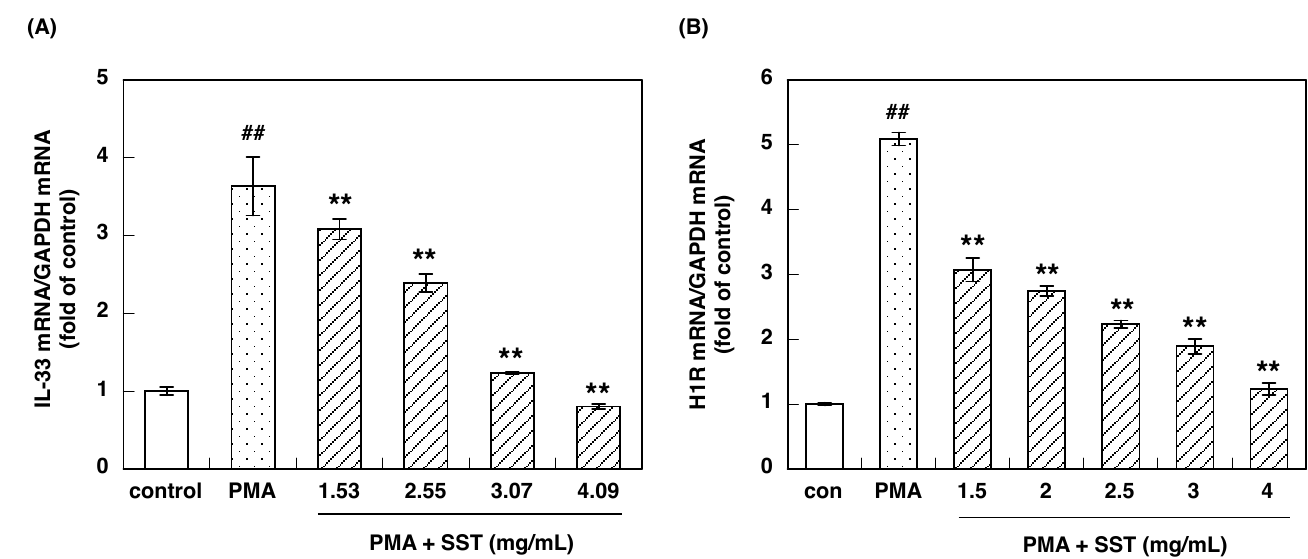
Figure 1. Effect of SST on PMA-induced up-regulations of IL-33 mRNA in Swiss 3T3 cells ( A ) and H1R mRNA in HeLa cells ( B ). The hot water extract of SST was incubated for 12 h before stimulation with 100 nM PMA. After stimulation with PMA for 3 h, the cells were harvested, and total RNA was prepared. IL-33 and H1R mRNA levels were determined using quantitative RT-PCR. Data are expressed as means ± SEM ( n = 3–4). ## p < 0.01 vs. control; ** p < 0.01, vs.